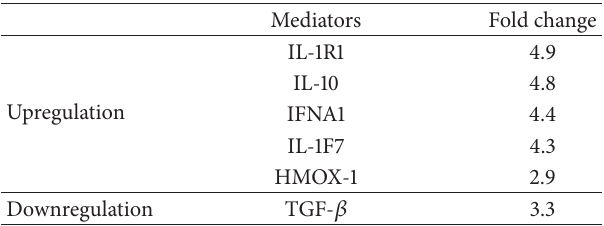
Table 3: Real-time PCR microarray: genes up- and downmodulated in kidney biopsies from DGF versus no DGF